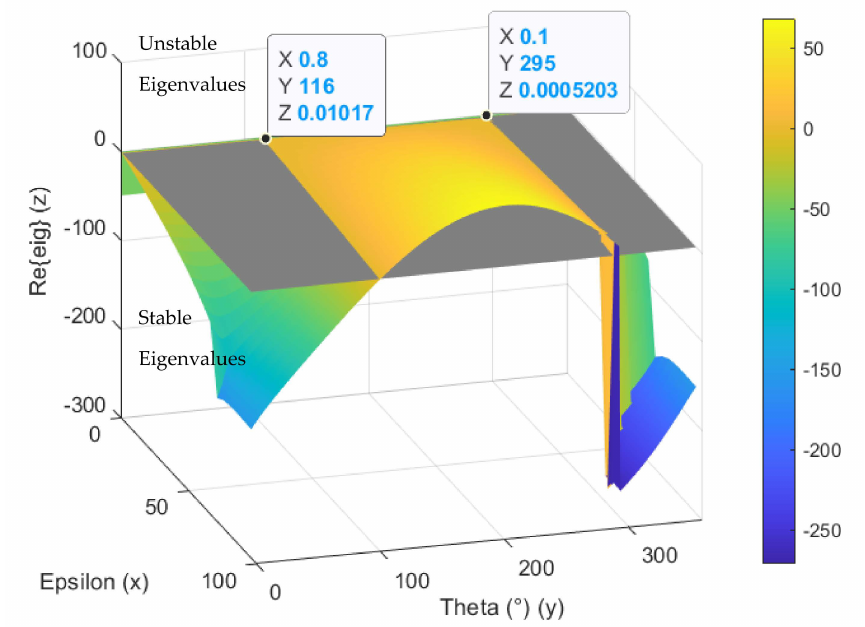
Figure 8. Critical eigenvalue dependence on parameters ε and Θ for unbalance frequency 50